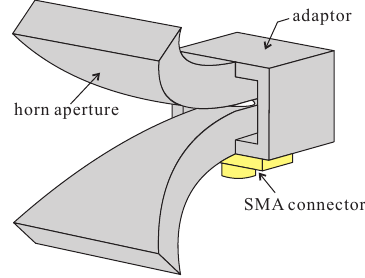
Figure 6. 3D view of the TEM horn